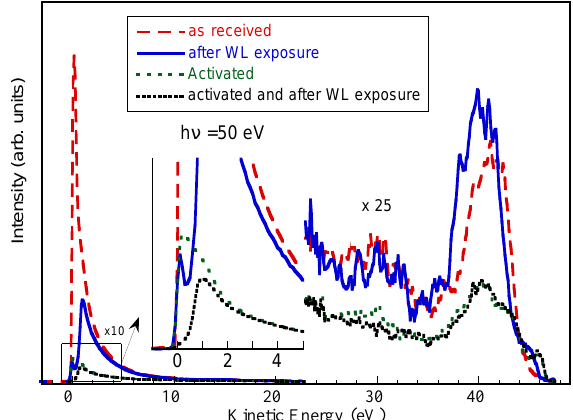
FIG. 9. (Color) The photoemission spectra, taken at 50 eV photon energy, of Si 707 as received, after WL exposure, after annealing in UHV (pressure during annealing was less than 5 3 10 2 9 mbar) at (cid:2) 300 6 30 (cid:3) ± C for 8 h (St 707-ac.), and after WL exposure of the annealed